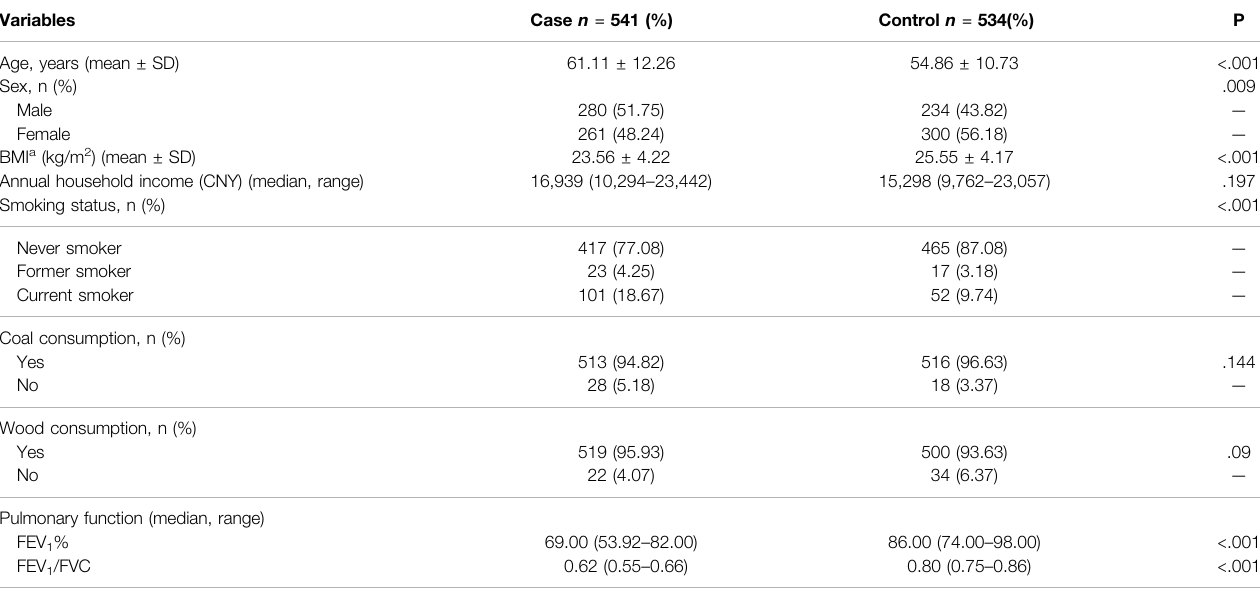
TABLE 1 | Clinical characteristics of the COPD and non-COPD groups.